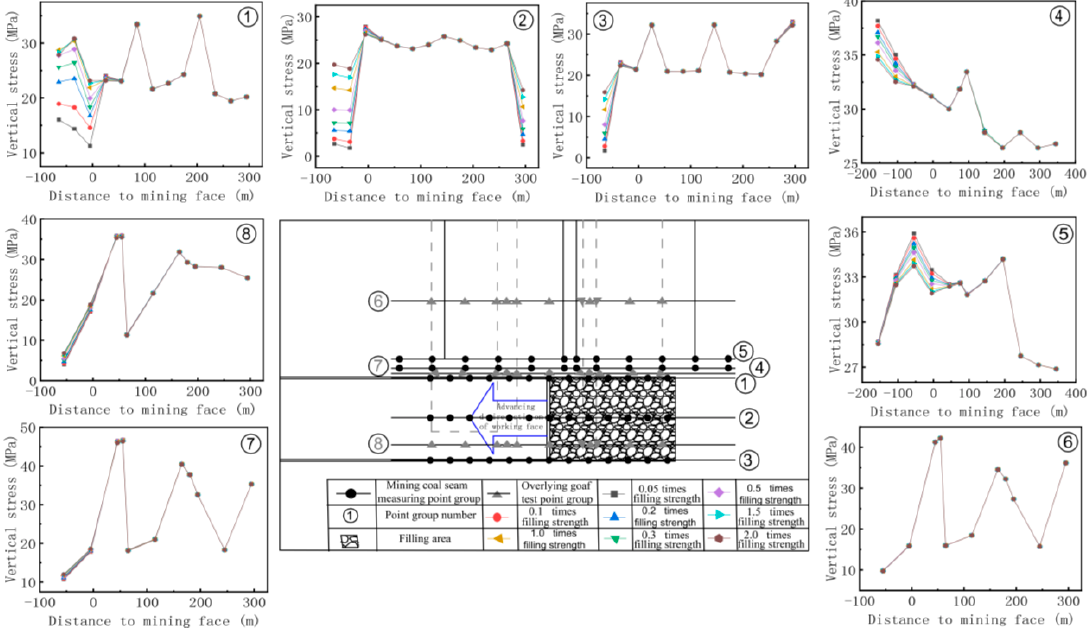
Figure A4. Distribution of the underground pressure (60 m).